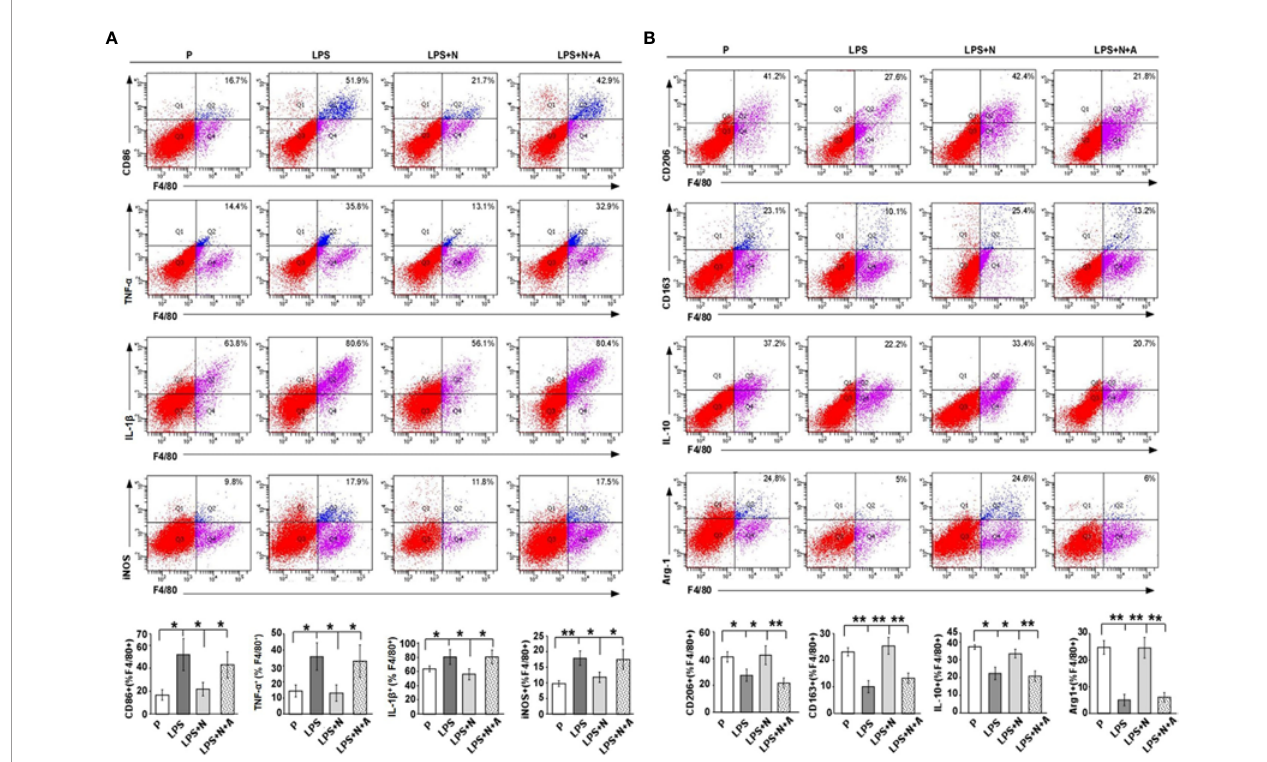
FIGURE 9 | FCM analysis results showed that nicotine prompted the polarization of M1 dM j to M2 dM j from LPS-induced PE-like mice. (A) FCM analysis of the percentage of CD86 + , TNF- a + , IL-1 b + and iNOS + dM j from different animal groups (n=10 each). Total leukocytes were gated using FSC vs. SSC and then gated for identifying CD68 + macrophages. Gating strategy was the same to that used to identify CD68 + CHAT + cells. (B) FCM analysis of the percentage of CD206 + , CD 163 + , IL-10 + and Arg-1 + dM j from different animal groups (n=10 each). *P < 0.05 and **P <